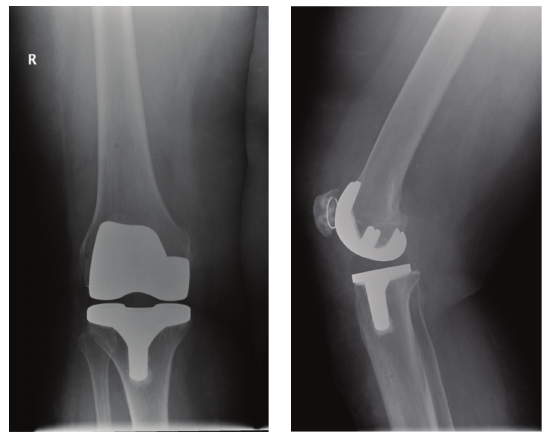
Figure 1: Preoperative weight-bearing AP and lateral radiographs clearly showing tricompartmental knee OA (K-L Grade IV).